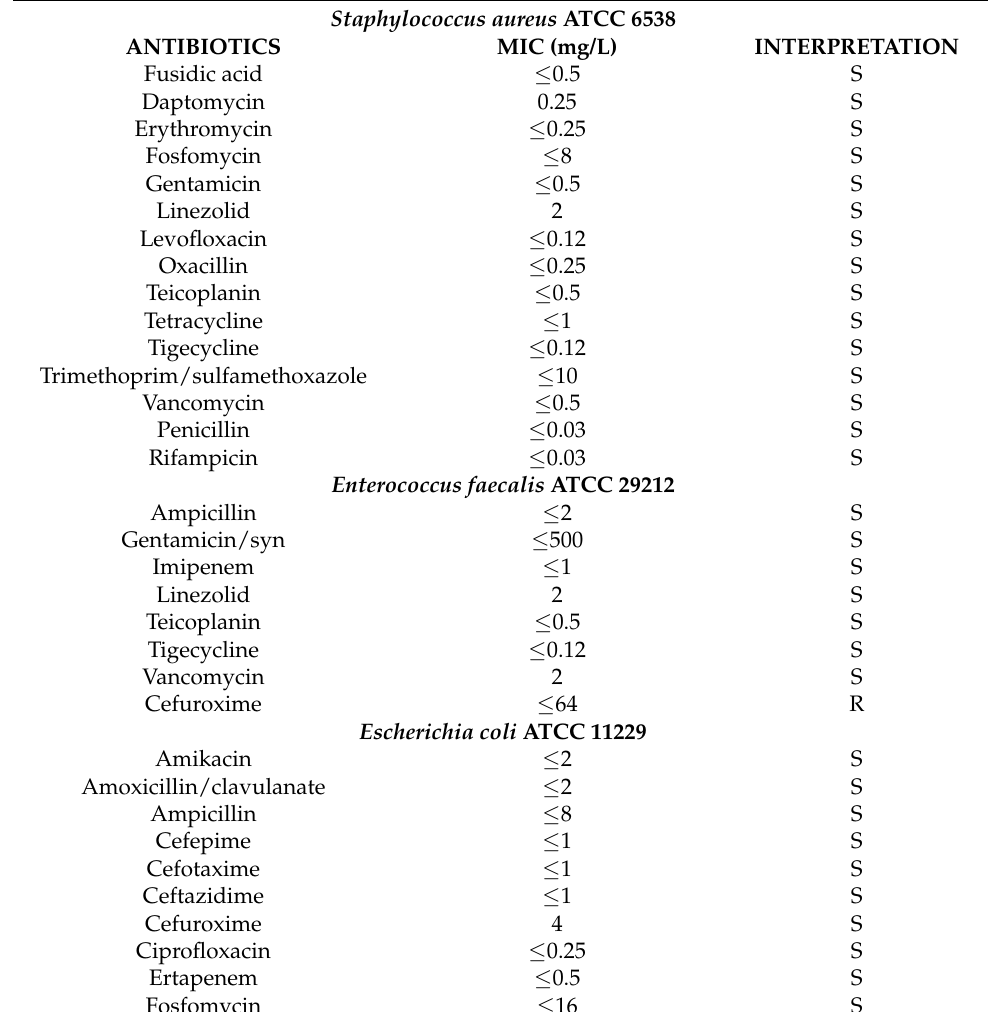
Table 1. Antibiotic resistance profile of the ATCC bacterial strains: S. aureus , E. faecalis , E. coli , and K. pneumoniae